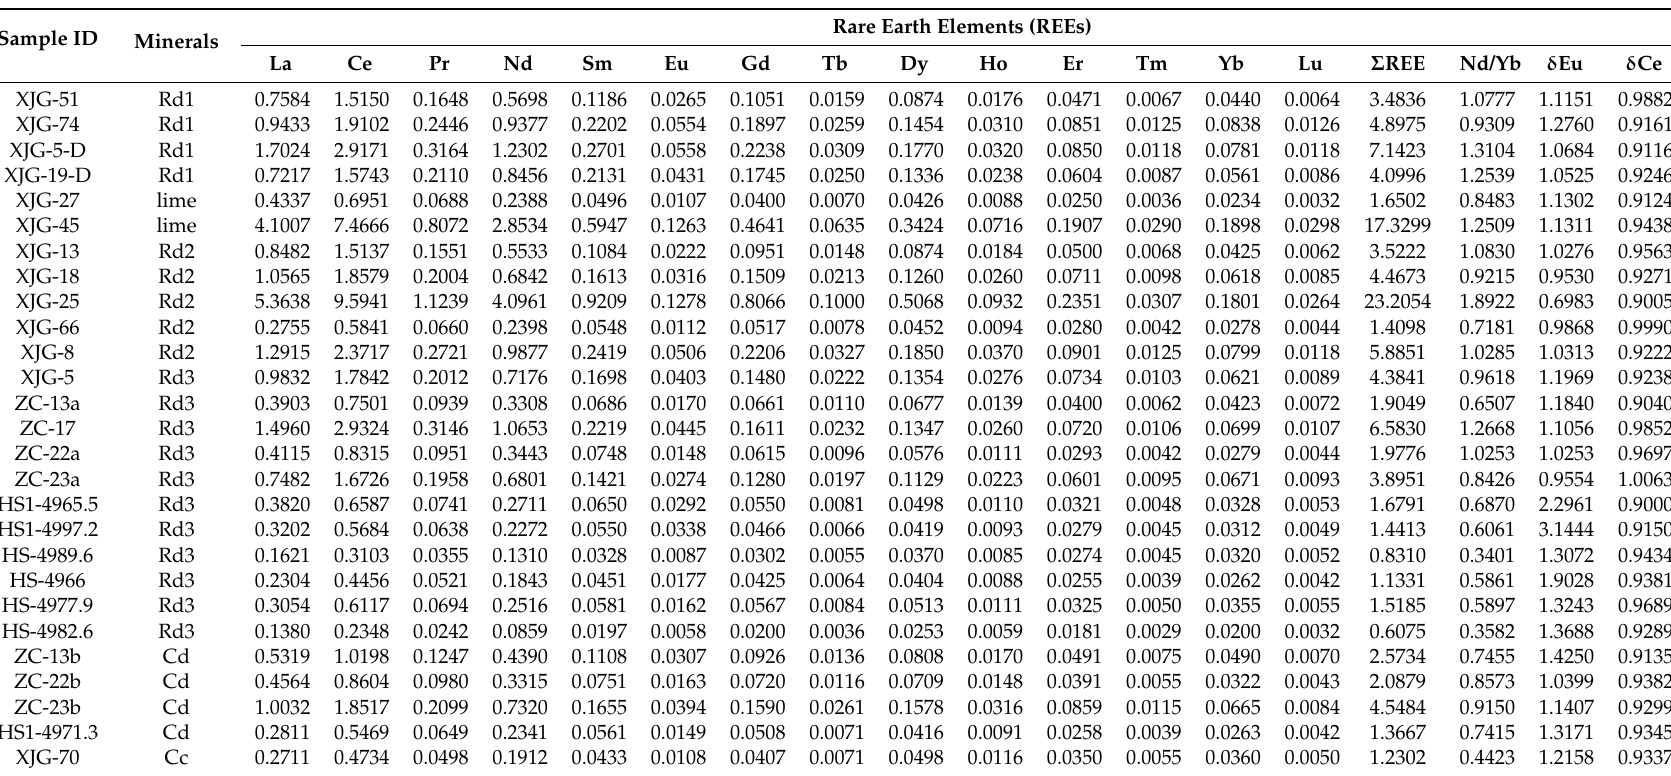
Table 3. Rare earth element data of limestone and dolomite in Middle Permian in SW Sichuan Basin. XJG—Xinjigu outcrop; ZC—Zhangcun outcrop; HS1— Well